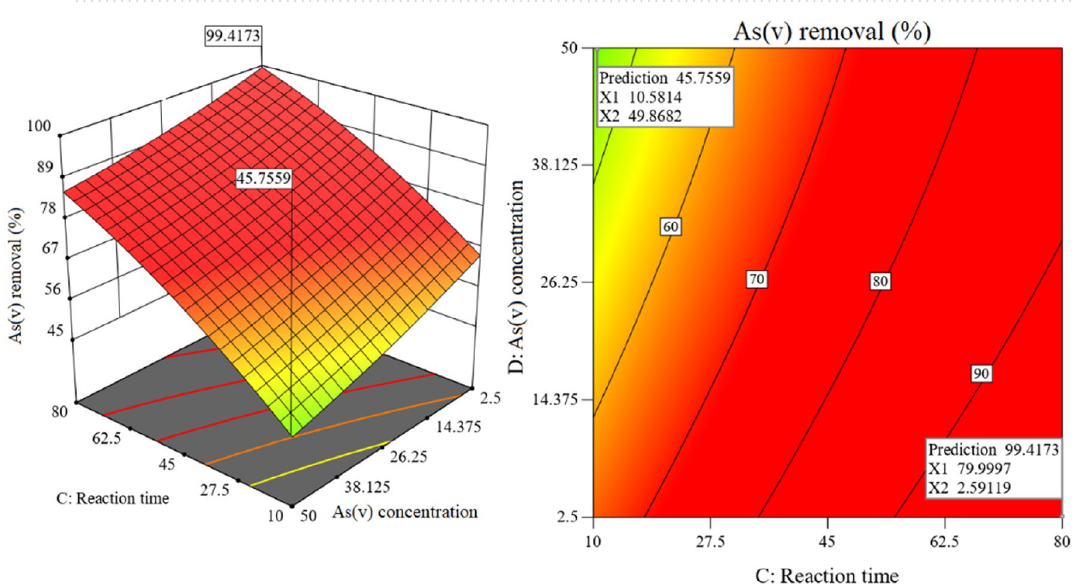
Figure 7. Interaction of reaction time and As(V) concentration on system response (pH = 3, MOF dose = 0.4 g/L). Design-Expert v13 software was used to create this figure (https:// www. state ase. com/ docs/